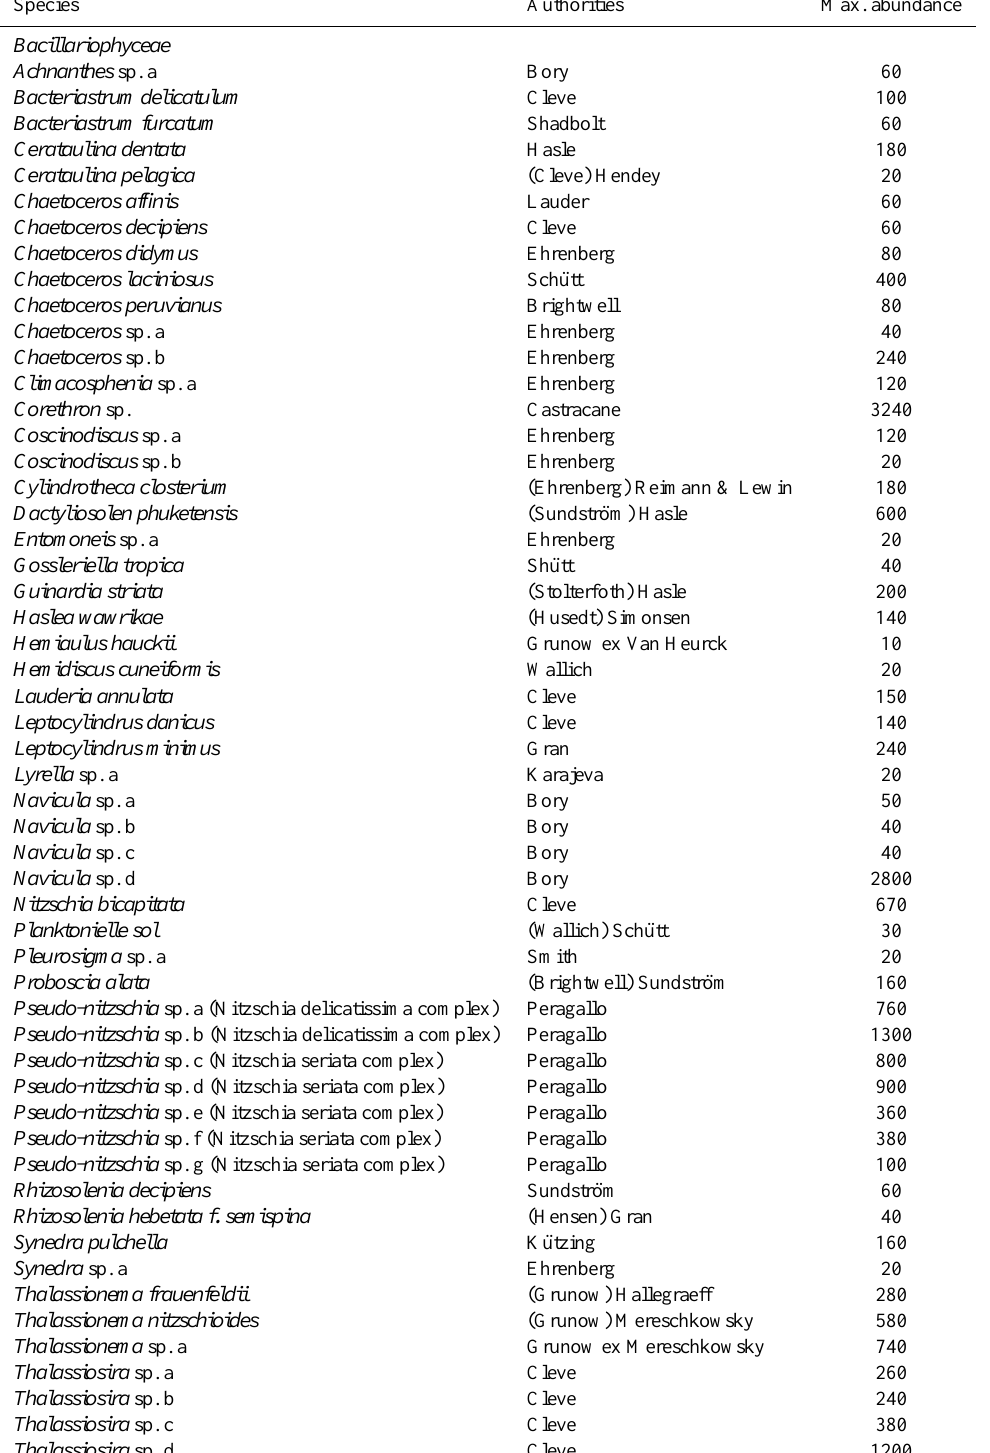
Table 1. List of microphytoplanktonic species encountered in hydrological bottle samples during DYNAPROC 2 cruise, with maximal abundance recorded in samples in cells per